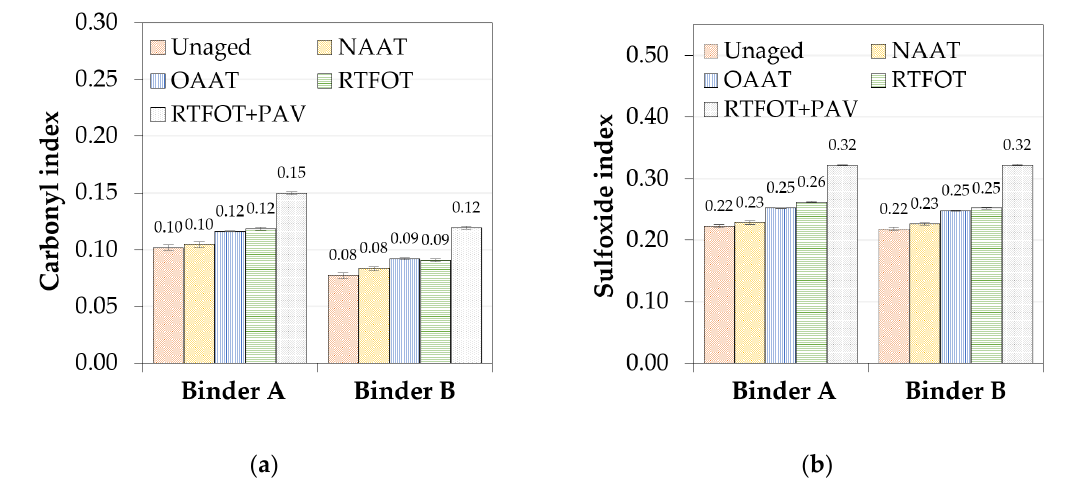
Figure 9. Aging indices: ( a ) carbonyl and ( b ) sulfoxides.